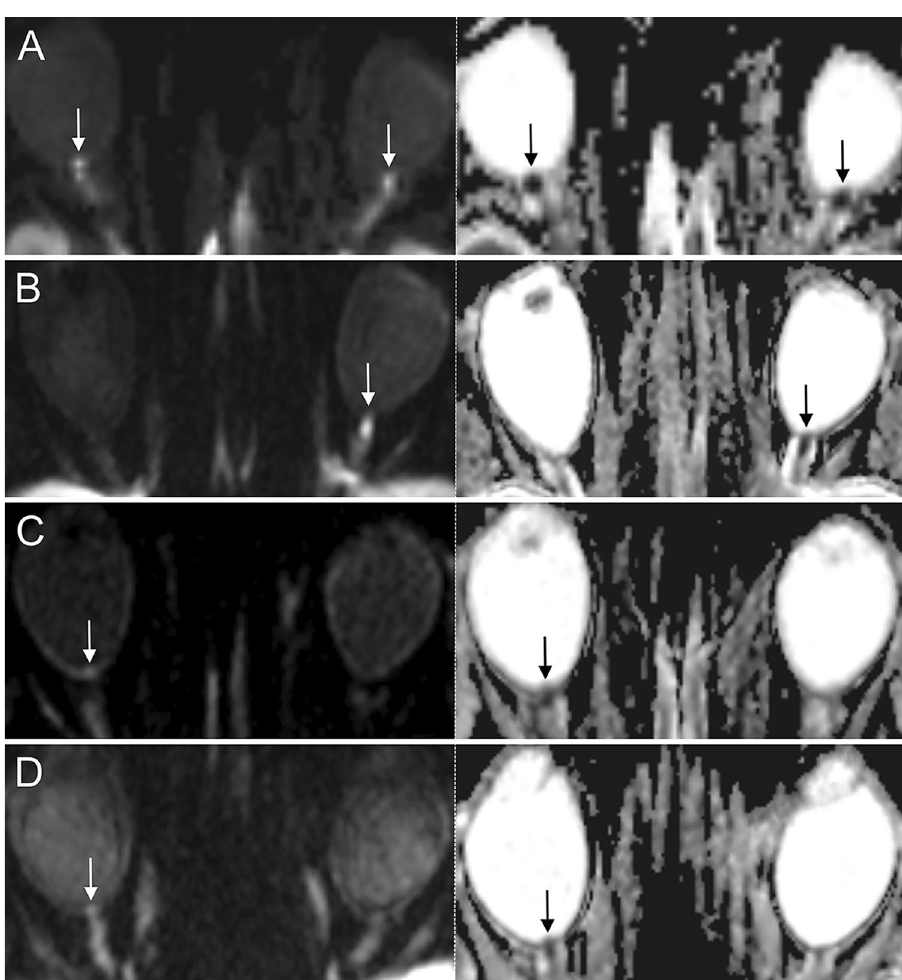
Figure 2. Examples of 3 T DWI-MRI in 4 GCA patients presenting with acute arteritic AION (left row: DWI b = 1000 s/mm2, right row: corresponding ADC images). ( A , B ): Distinct findings of ONH restricted diffusion in 2 patients with AION (white arrows; bilateral ( A ) and left-sided ( B )). Note the marked qualitative ADC reduction in both cases (black arrows). ( C , D ) Subtle findings of ONH restricted diffusion (white arrows) and corresponding visually qualitative ADC reduction (black arrows) in 2 patients with right-sided AION. Abbreviations: AION, anterior ischemic optic neuropathy; DWI-MRI, diffusion-weighted magnetic